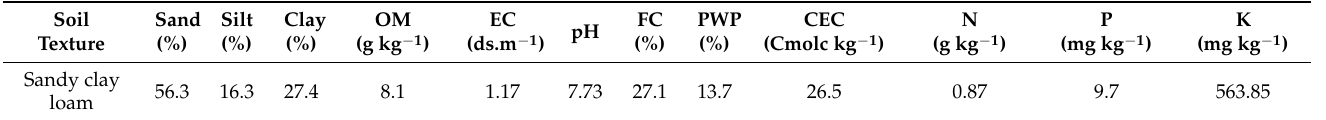
Table 8. Physico-chemical properties of field soil (average of two